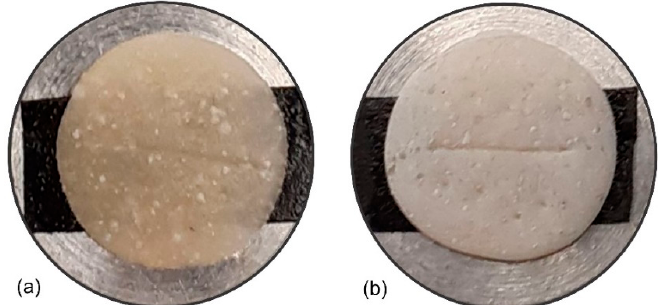
Figure 3. Optical microscopic images: ( a ) control composite (without healing materials) and ( b ) self-healing composite.